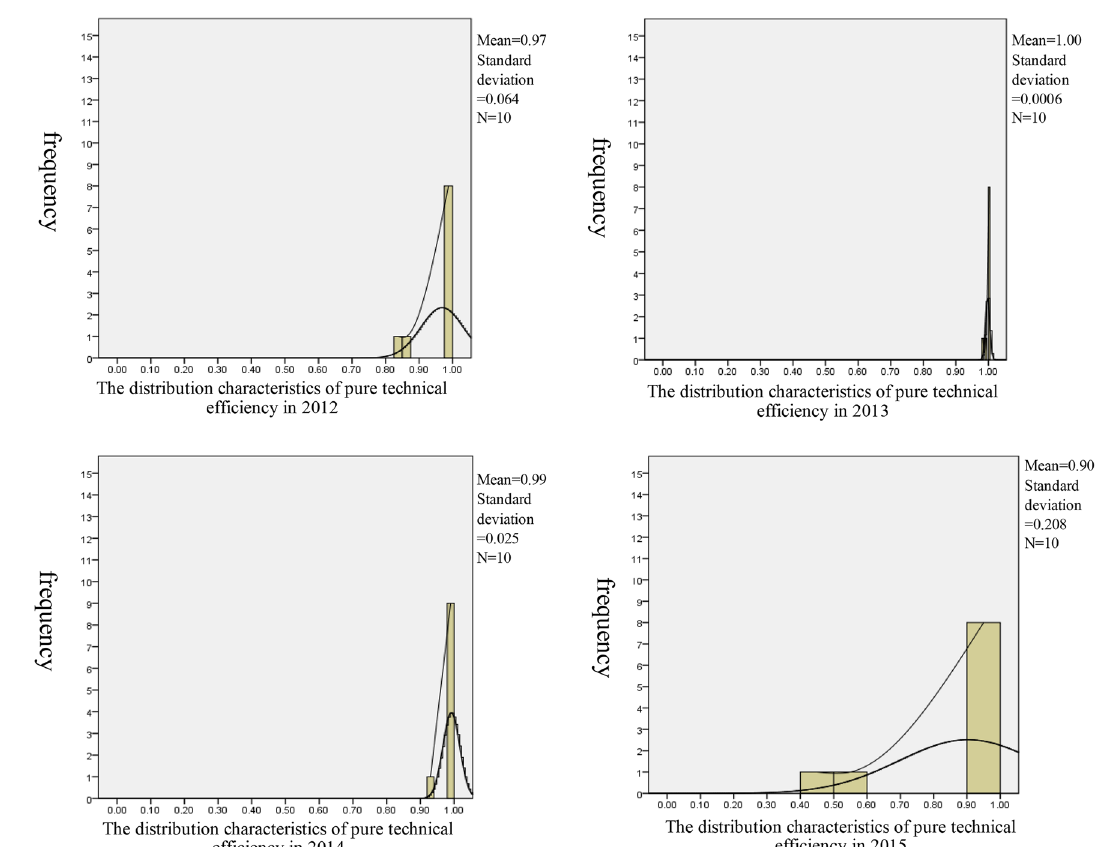
Fig. 3 Frequency of pure technical innovation efficiency in